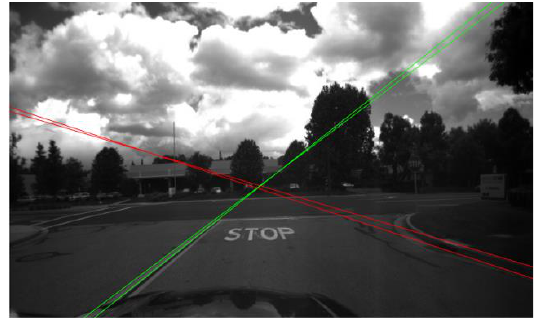
Figure 6. Hough lines plotted on